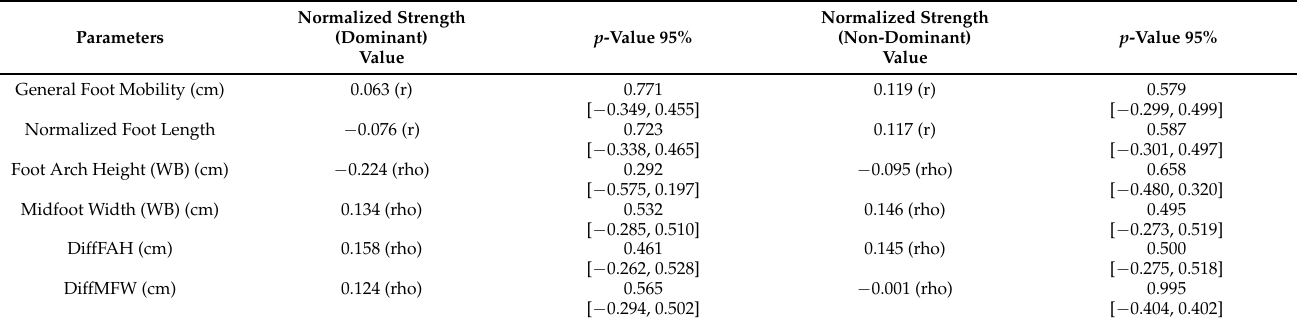
Table 3. Correlations between general foot mobility, normalized foot length, foot height, foot width, DiffFAH, DiffMFW, and normalized foot strength for dominant and non-dominant